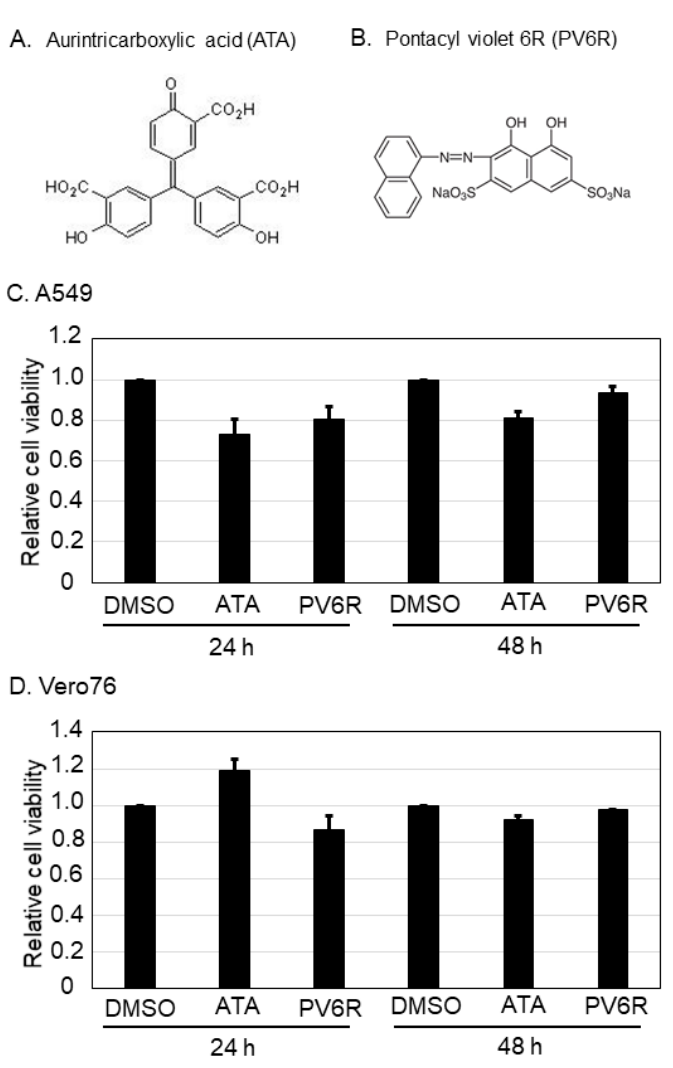
Figure 1. Chemical structure of aurintricarboxylic acid (ATA) and pontacyl violet 6R (PV6R), and their cell viabilities upon the treatments on A549 and Vero 76 cell lines. Chemical structure of ATA ( A ) and PV6R ( B ). Either A549 ( C ) or Vero 76 ( D ) cells were treated with 500 μ M of ATA and 200 µ M of PV6R for 24 h or 48 h, and their cell viabilities were measured using CellTiter-Glo. Relative cell viability which was normalized with the DMSO control treatment as 1.0 was shown. Data were collected from at least three independent experiments, and provided data correspond to the mean +/ −